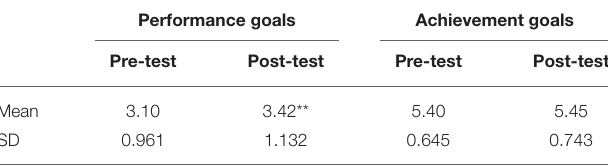
TABLE 9 | Results from the pre- and post-test questionnaires for performance-, and achievement goals ( n =